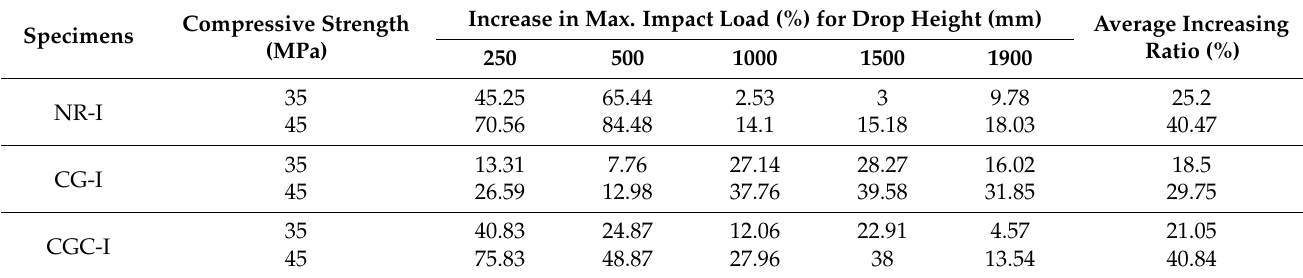
Table 11. Summary of the concrete compressive strength effects on the impact force.